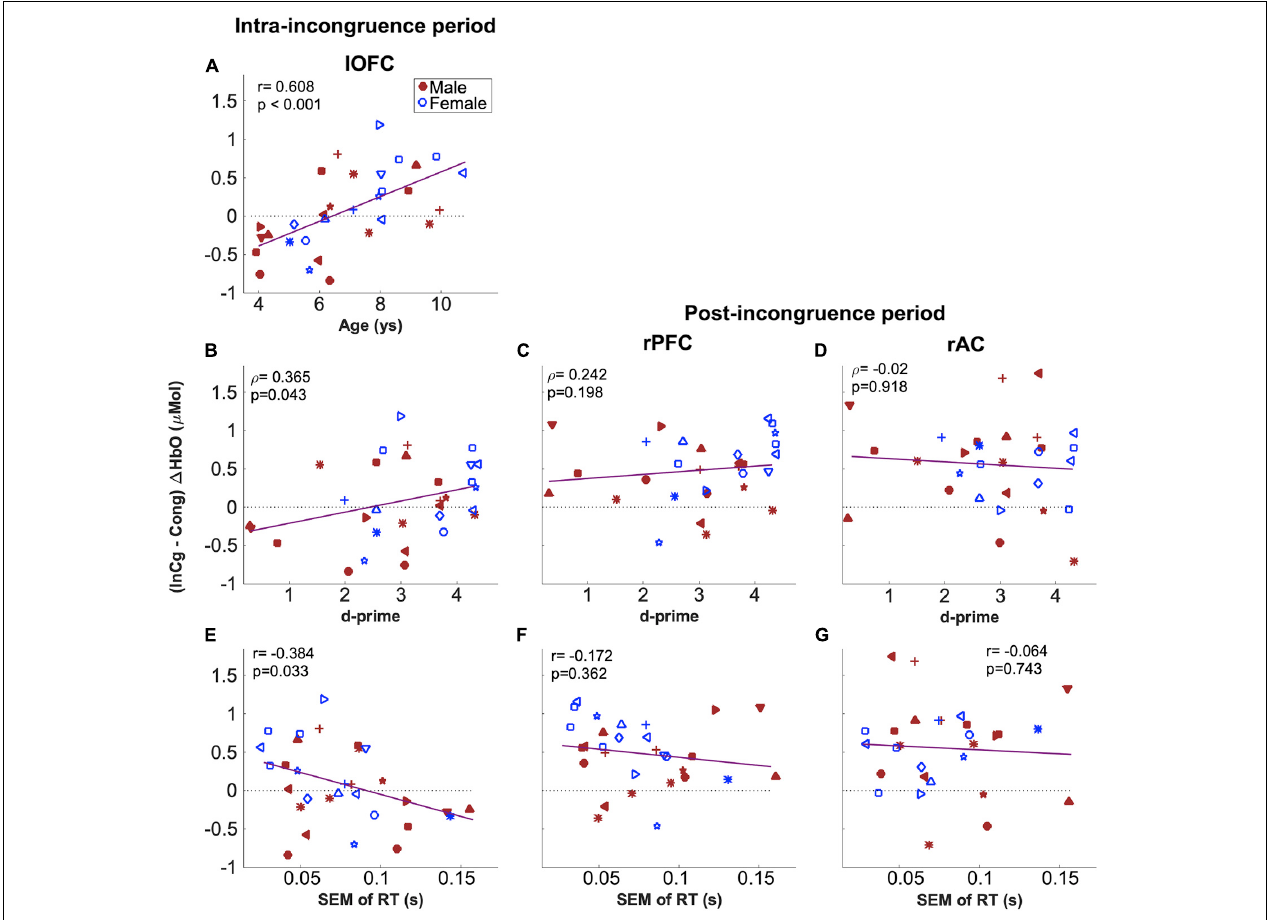
FIGURE 10 | Correlations between (InCg – Cong) (cid:49) HbO amplitudes and the ages and behavioral measures of children. Panels (A,B,E) shows the results for (InCg – Cong) (cid:49) HbO amplitudes in the intra-incongruence period in the lOFC with the ages, d-prime values and SEM of RTs for children, respectively. Panels (C,D) show the correlation results for (InCg – Cong) (cid:49) HbO amplitudes in the post-incongruence period for the rPFC and rAC with d-prime values. Panels (F,G) show the correlational results with SEM of RTs. The same symbols were used to indicate individuals as in previous figures; again, blue is for females and red for